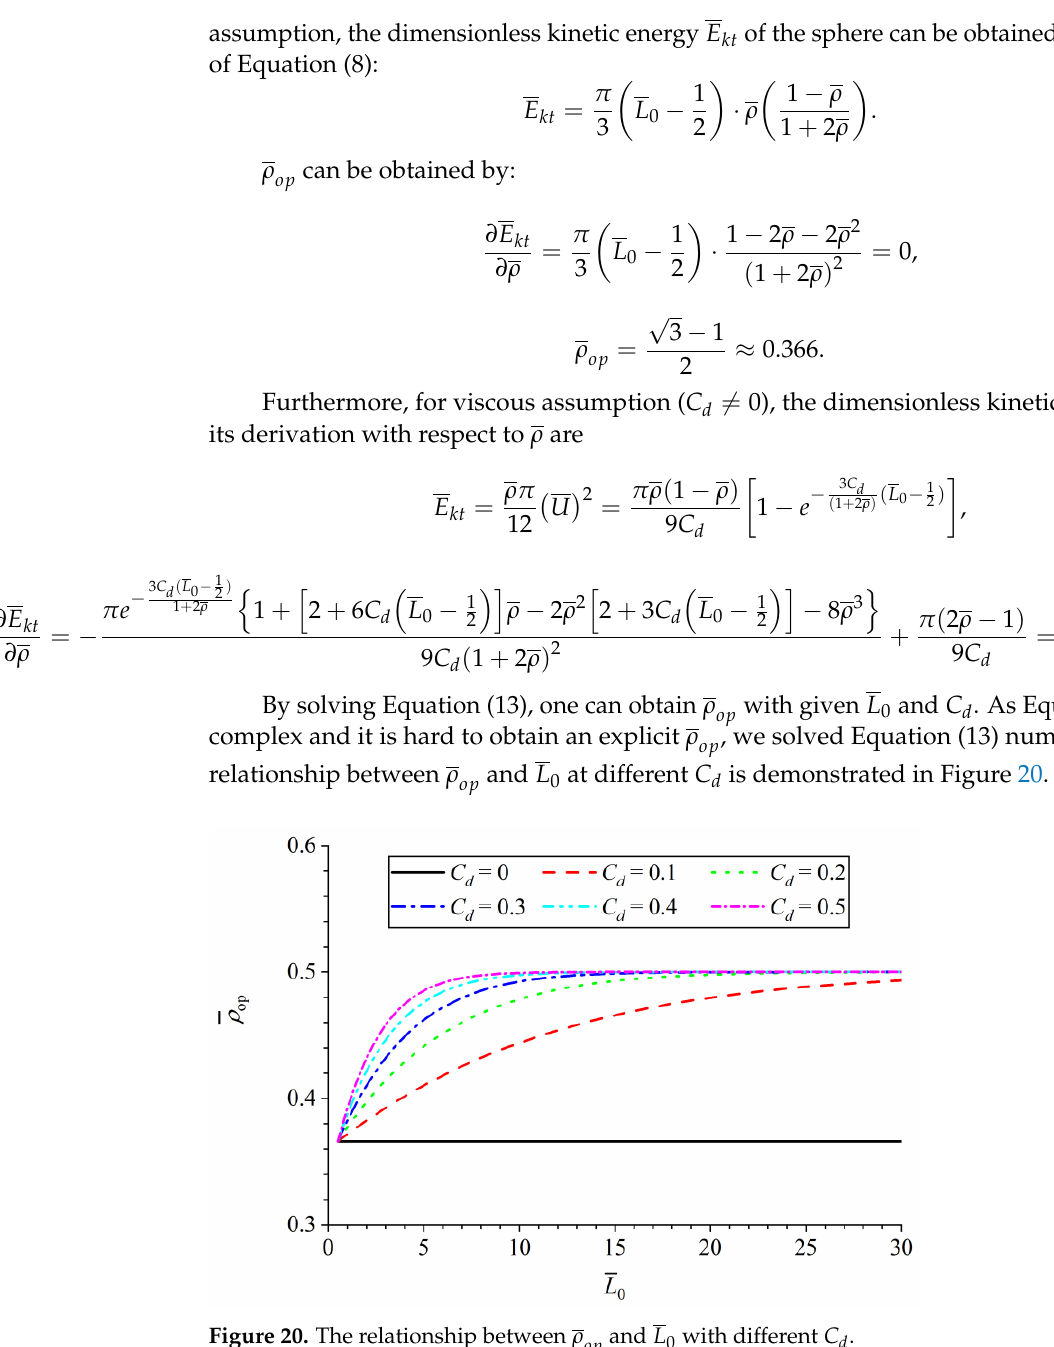
19 of 24 Figure 19. Dimensionless kinetic energy of the sphere versus dimensionless density of the sphere with h = 0.089 and 0 L = 2.31. On the other hand, we further considered the relationship of op  with 0 L and d C . First, we studied a simplified model with a non-viscous assumption, i.e., d C = 0. Under